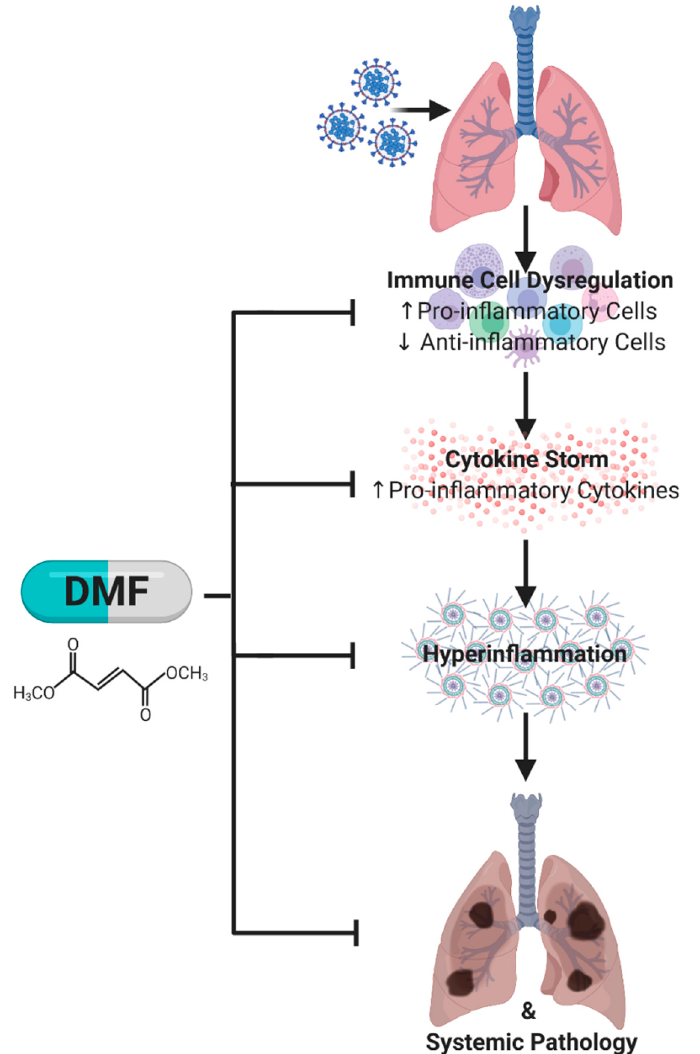
Figure 1. Simplified pathological pathway to lung (and systemic) injury in severe cases of COVID-19. Infection with the SARS-CoV-2 virus can lead to a dysregulated immune response in which pro-inflammatory cells dominate the immune cell population. These pro-inflammatory cells intensify cytokine production and release resulting in hyperinflammation. This hyperinflammatory state promotes lung (and systemic) pathology, which correlates with poorer prognosis. It is well documented that dimethyl fumarate (DMF) can modulate immune cell populations to shift the ratio of anti-inflammatory to pro-inflammatory cytokine production and release, which in turn reduces hyperinflammation and subsequent tissue injury.